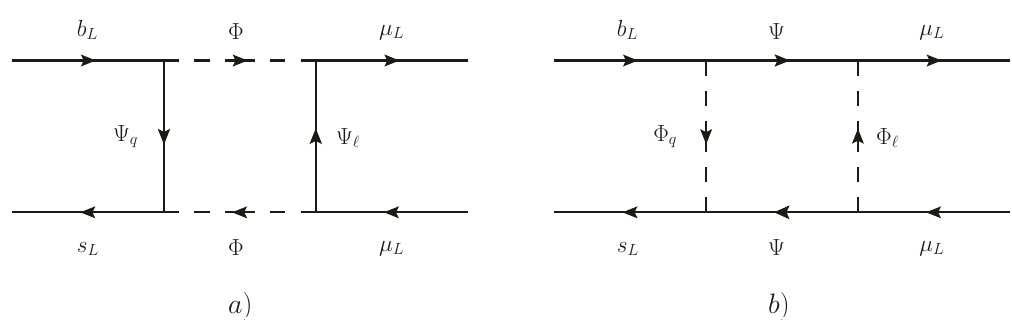
Figure 3 . Loop-level diagrams responsible for generating the NP contribution to b → sµ + µ − for the models of eq. (7.2) and eq.